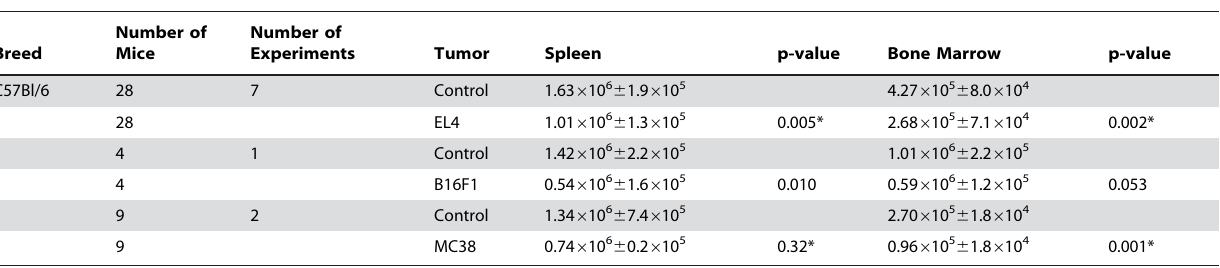
Table 1. Multiple tumor cell lines reduce NK cell numbers.